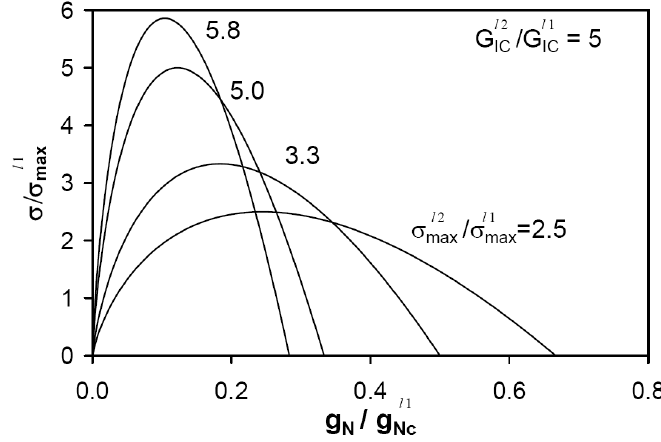
Figure 4. Shapes of the CZMs of the interfaces between the rods (level 2 or meso-structure).